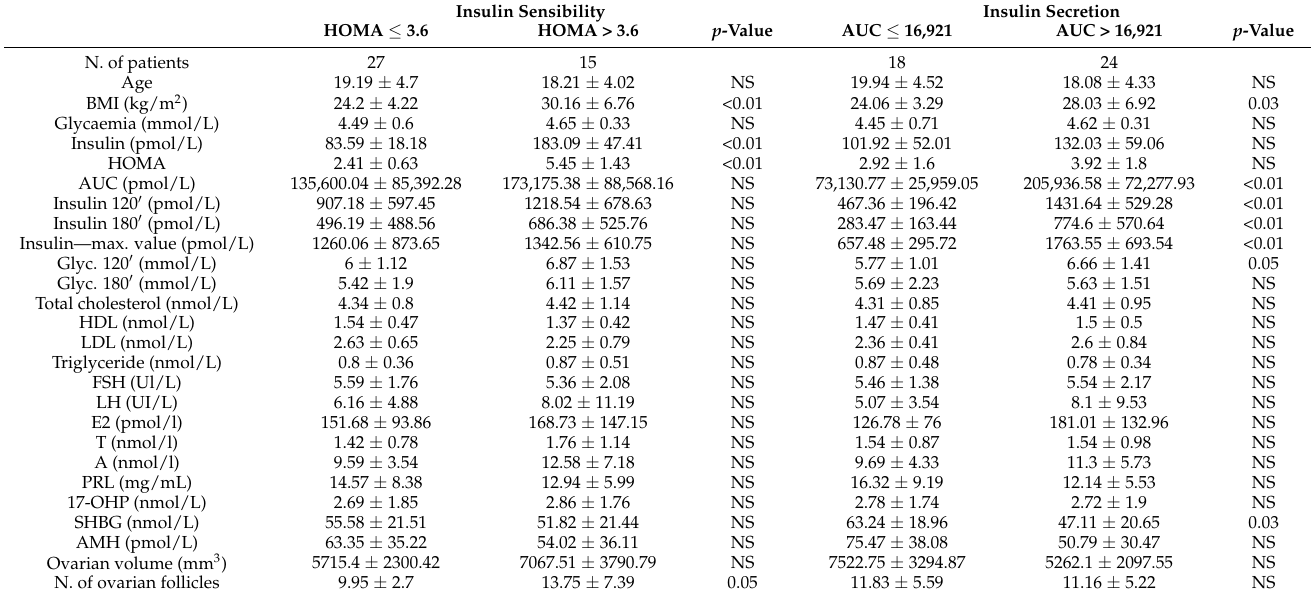
Table 2. Anthropometric, hormonal, and metabolic characteristics in relation to insulin sensibility and secretion. Values are mean ± SD. Insulin Sensibility Insulin Secretion HOMA ≤ 3.6 HOMA > 3.6 p -Value N. of